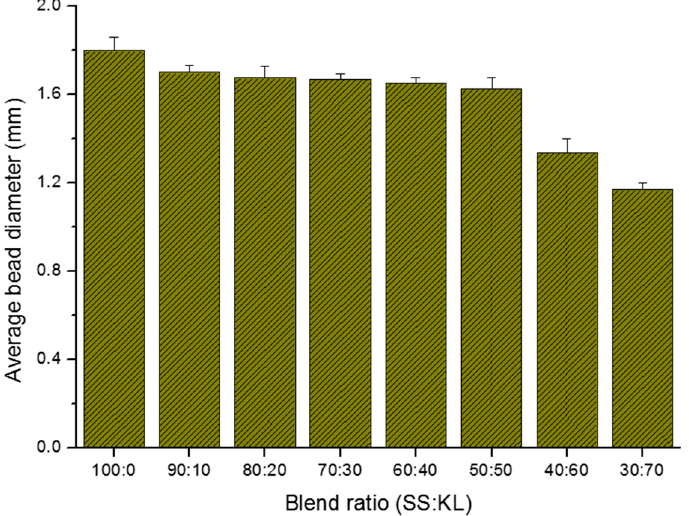
Figure 2. Effect of the SS/KL blend ratio on the average diameter of the as-prepared SS/KL beads. Table 1. Elemental analysis data of sericin/lignin beads with various blend ratios. Blend Ratio